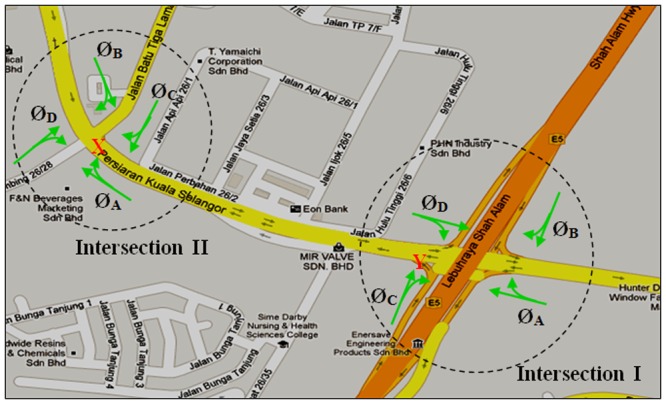
Real-world fixed-time traffic systems in Shah Alam, Malaysia.